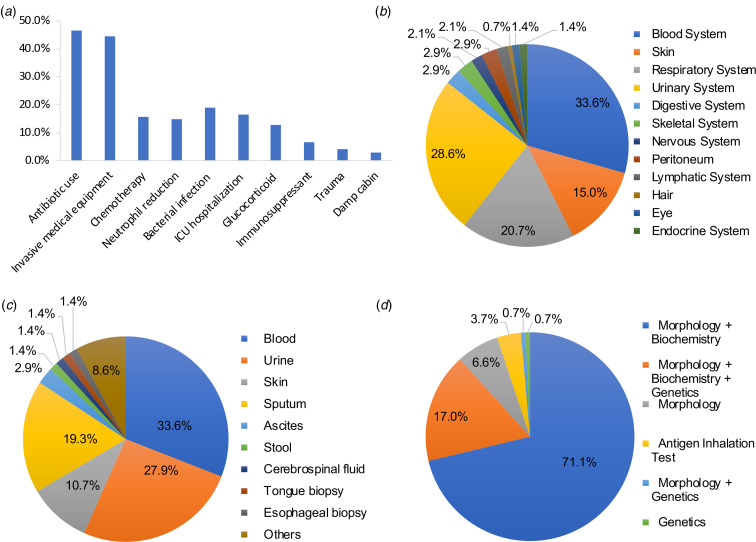
Proportions of 140 cases on risk factors (a), infected tissues (b), test samples (c) and testing methods (d).